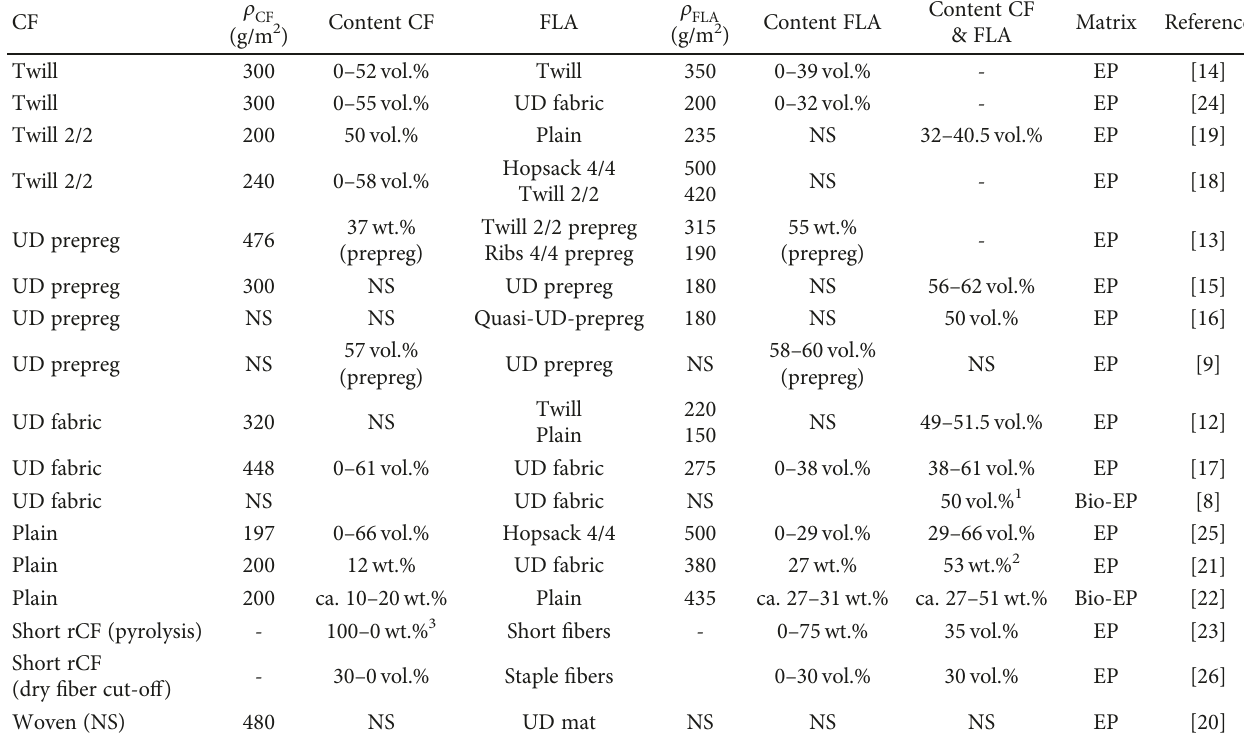
Table 3: Overview of the components used for the manufacture of hybrid carbon/ fl ax